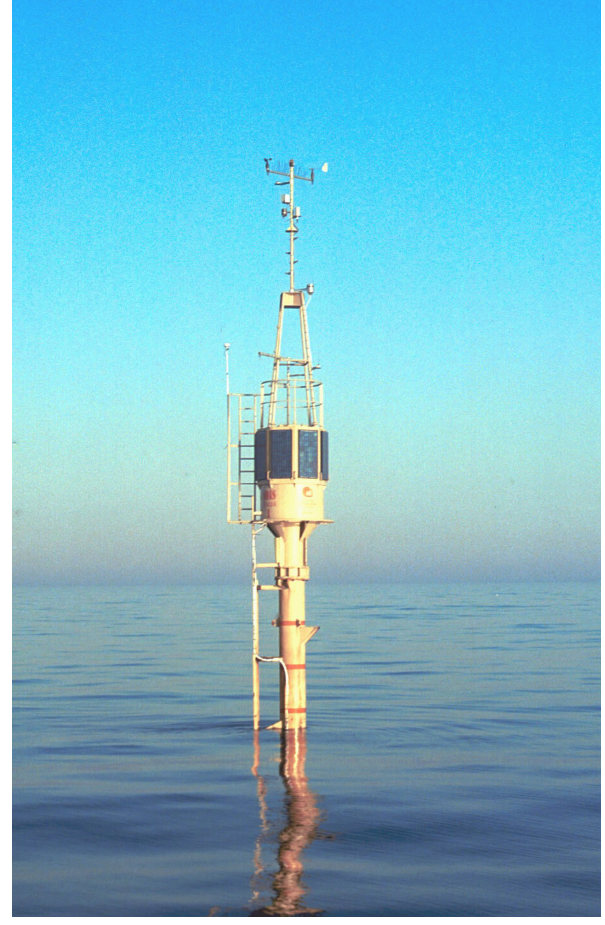
Fig. 1. Photo of the ODAS Italia 1 buoy deployed in the Ligurian Sea, showing meteorological sensors on the superstructure and the small laboratory, surrounded by the solar panels, hosting the acqui- sition and transmission systems.